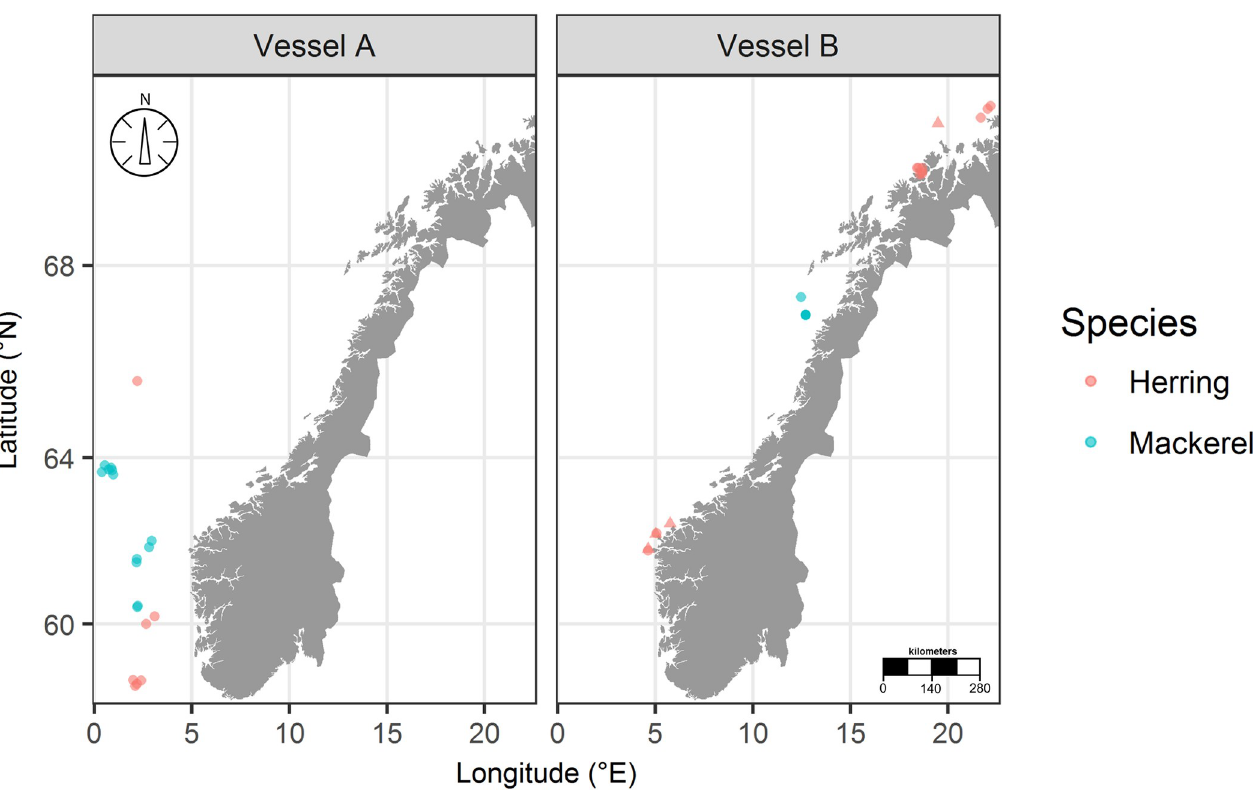
Fig 1. Spatial positions of mackerel and herring slipping events for Vessel A and Vessel B. Triangles denote slipping events not included in the analysis due to no behaviour being recorded; circles denote slipping events included in the analysis. Note that some points overlap.